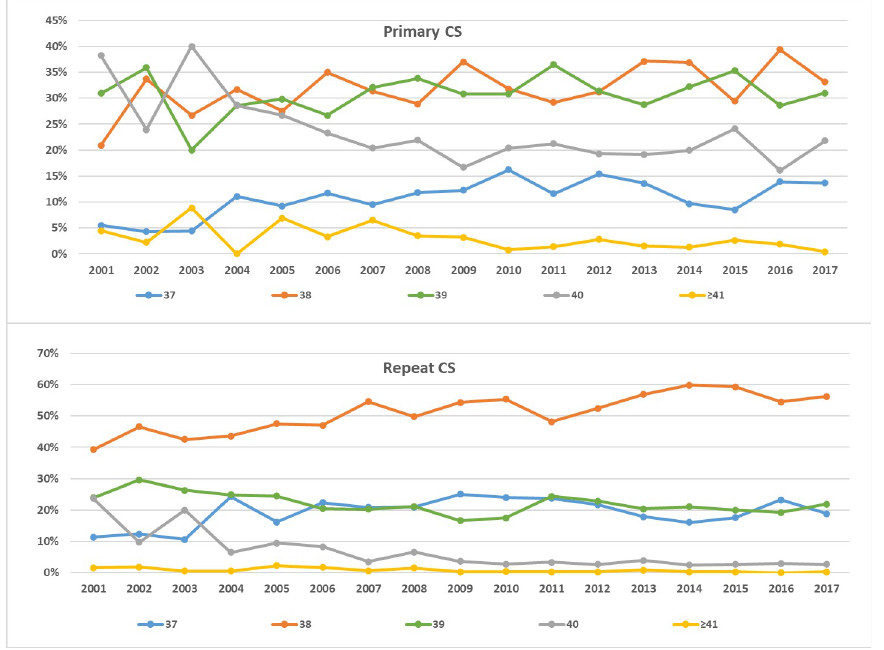
Fig 4. Timing of CS delivery trends from 2001 to 2017. (A) Among primary CS. (B) Among repeat